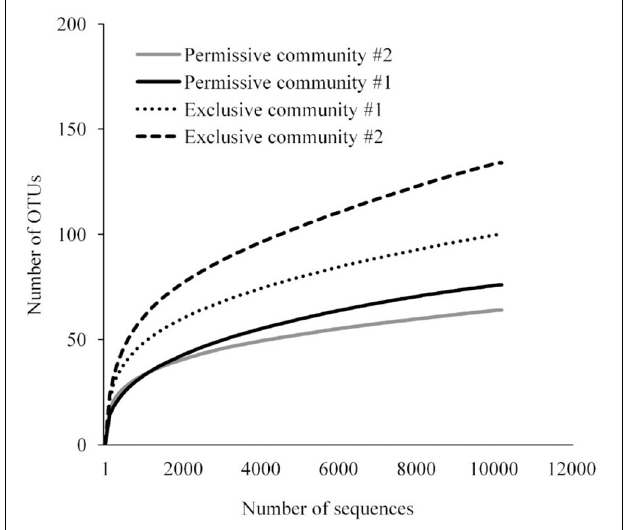
FIGURE 2 | Rarefaction curve for bacterial 16S rRNA OTUs at 97% of similarity for Salmonella exclusive and permissive cecal communities.